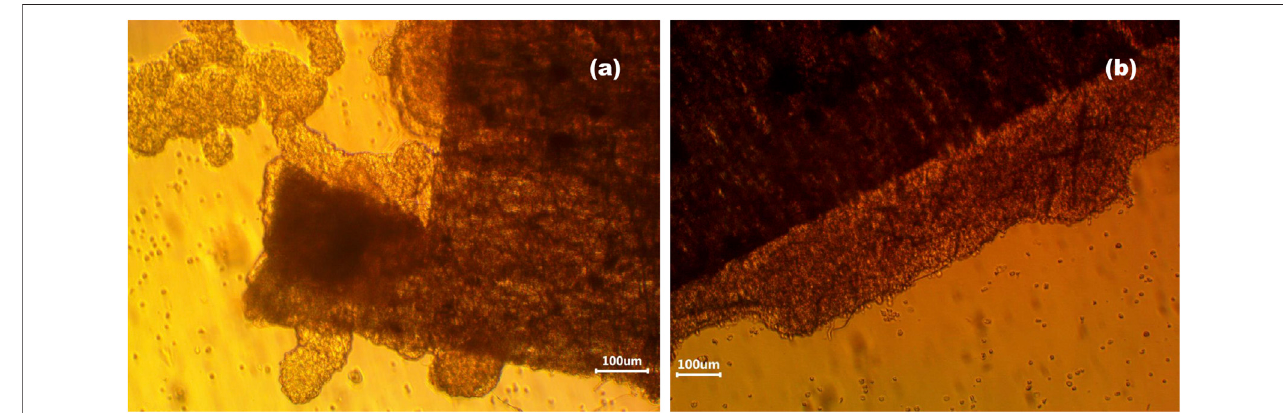
FIGURE 8 | Optical photographs of RIN-M cells on the 10th day of culture on (A) PHB and (B) PHB-PPyI scaffolds.